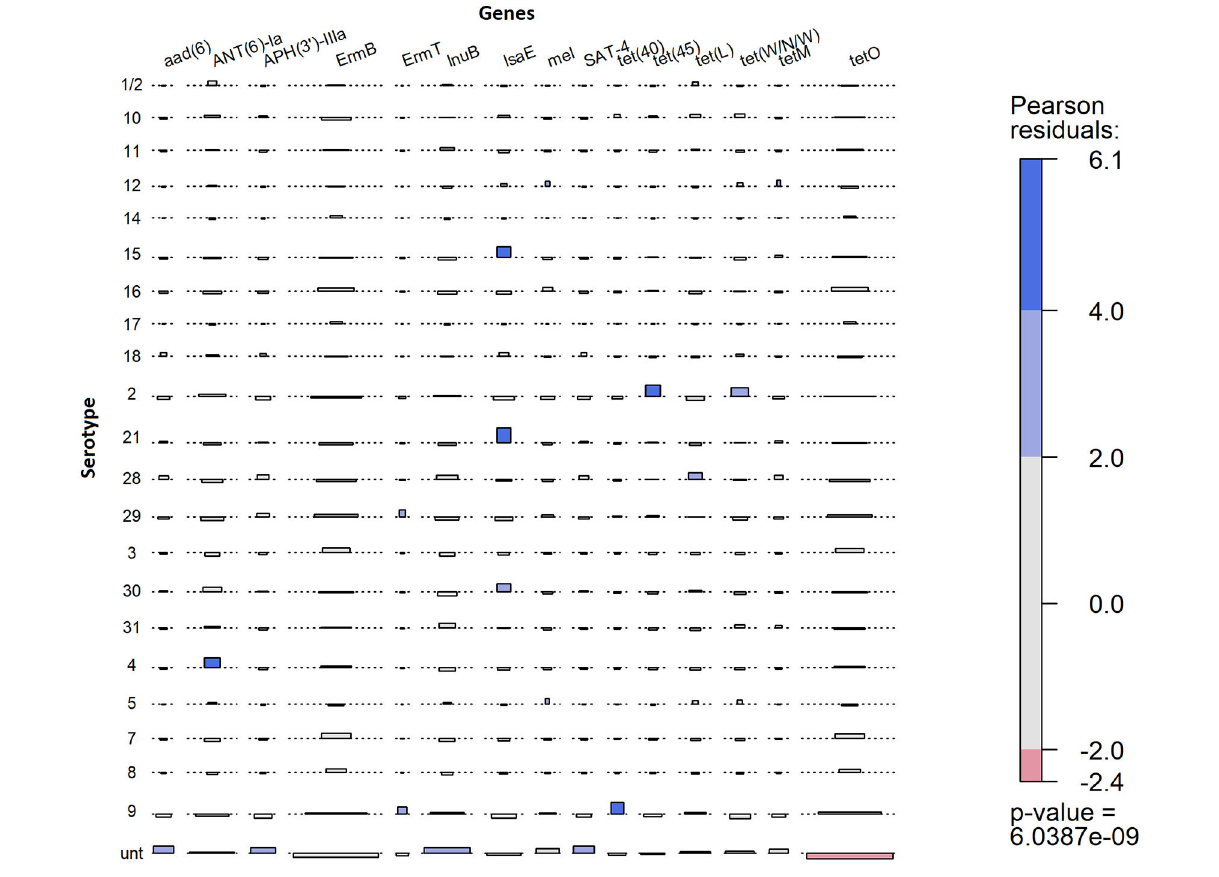
FIGURE 6 | Association plot for presence of AMR genes in 273 S. suis isolates belonging to different serotypes. Generated using Pearson’s chi-squared test of independence of multi-way contingency table. Shade represents a degree of departure from expected values; blue for higher and red for